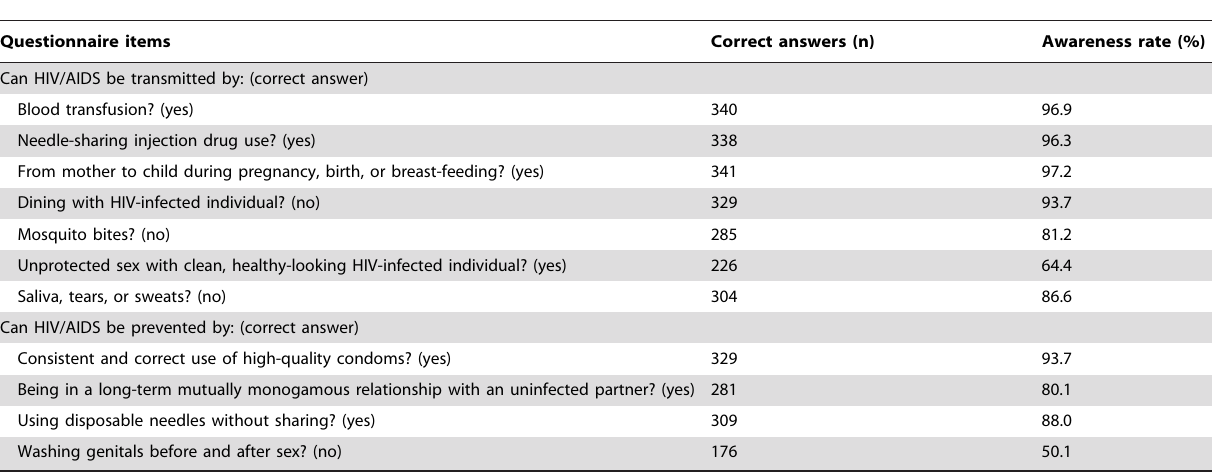
Table 2. Awareness of HIV transmission routes and prevention methods (n